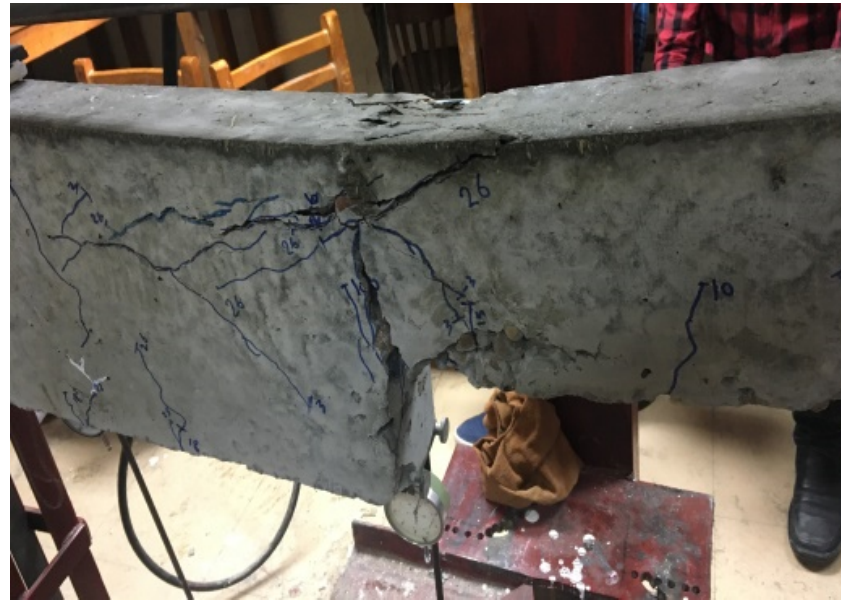
Figure 9. The crack pattern of beam B1.